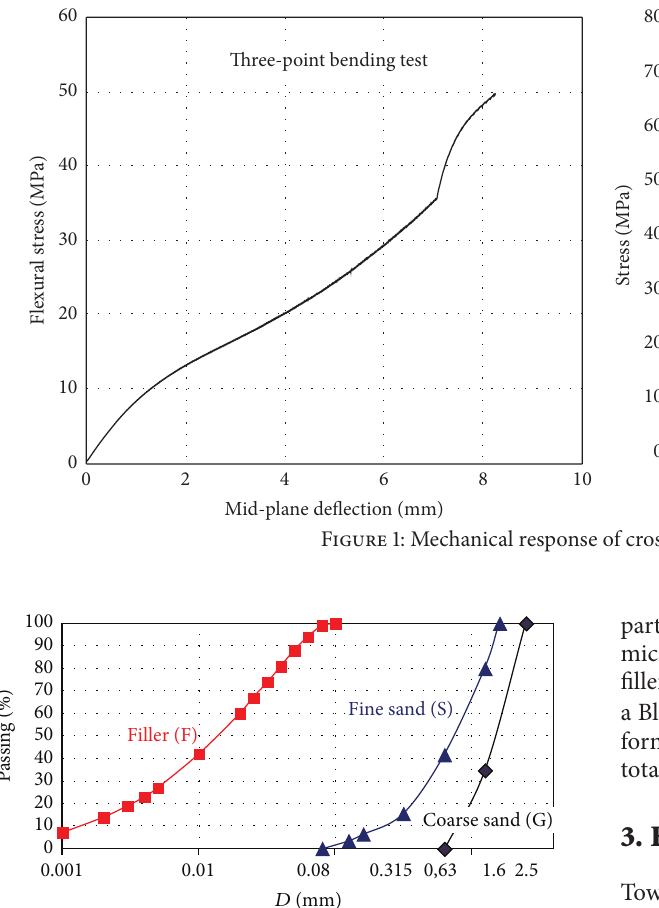
Figure 2: The size distribution of the used filler, sand, and